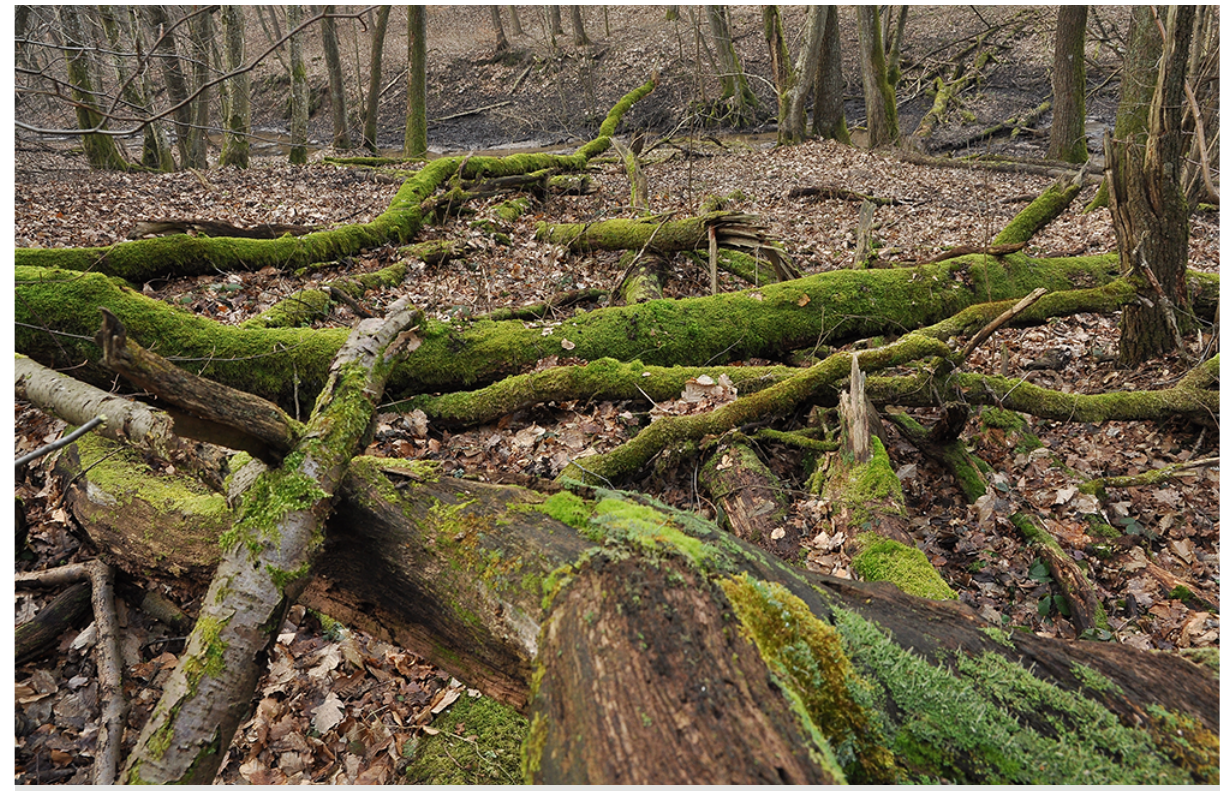
Fig. 2 The habitat of Ophiocordyceps stylophora in Kumiela (Dzikuska) Stream in Elbląg. February 28, 2014. Photo – P.